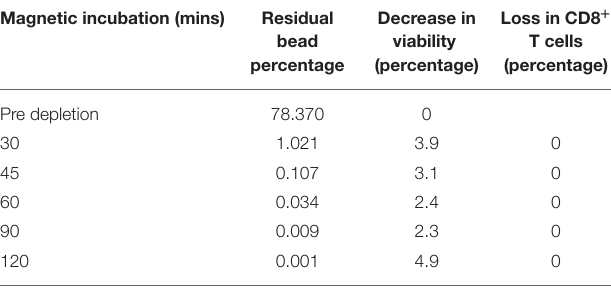
TABLE 3 | Bead depletion efficiency.